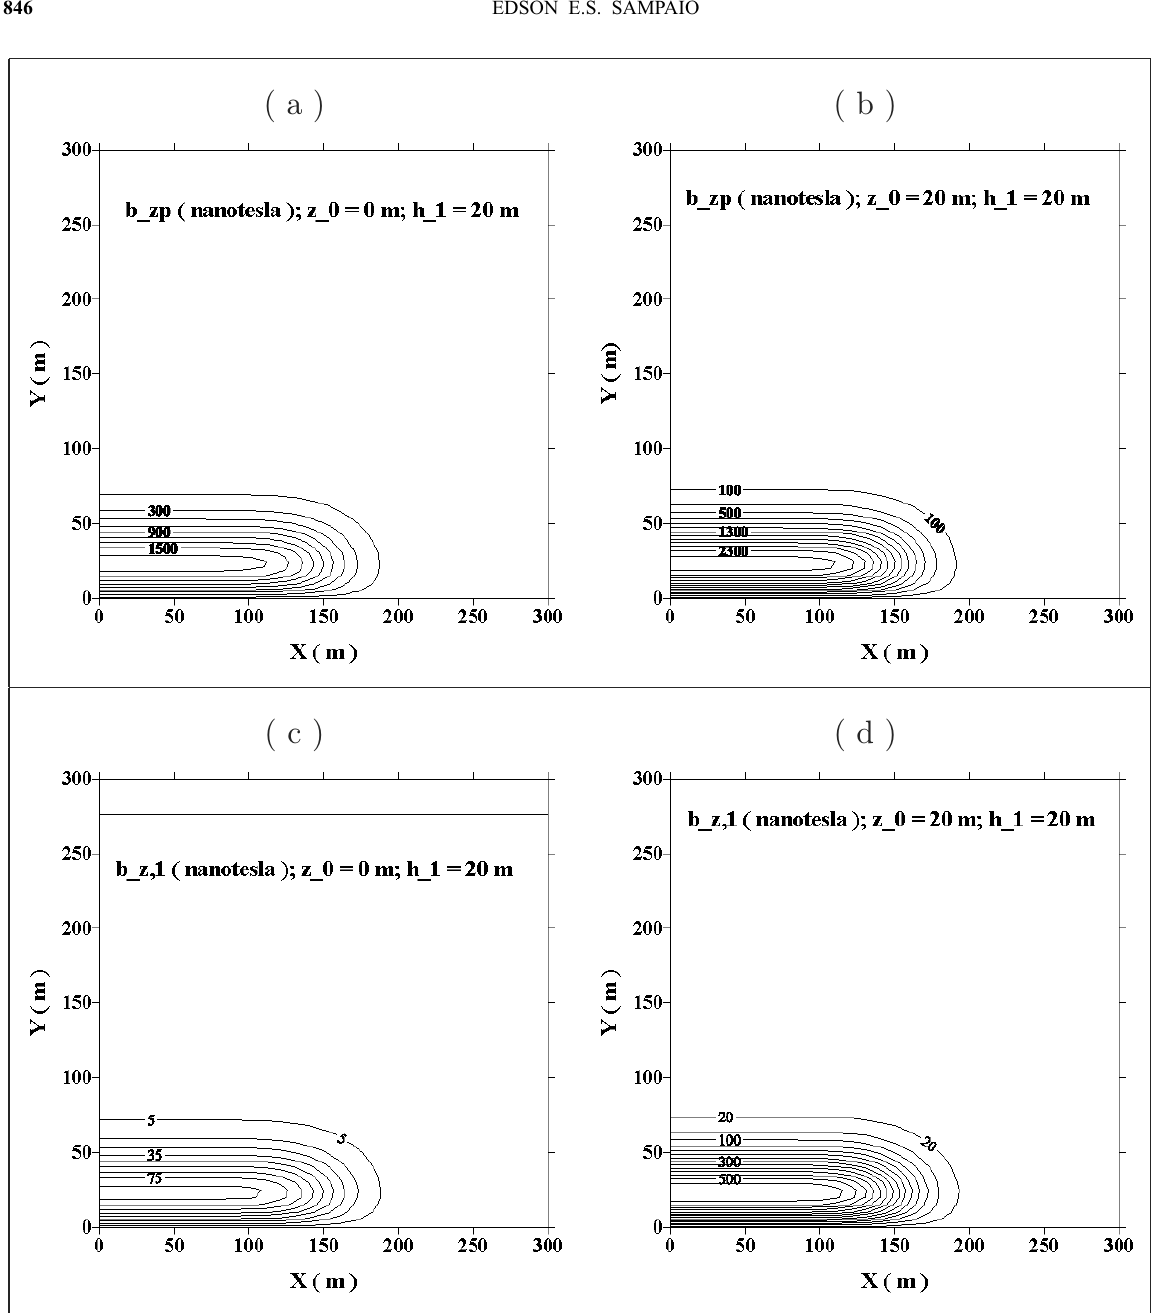
Fig. 5 – Contour maps of the vertical component of the magnetic field for the case of a water layer with h 1 = 20m and σ 1 = 3S/m and a substratum with σ 2 = 0 . 3S/m. Primary: b zp . Total: b z , 1